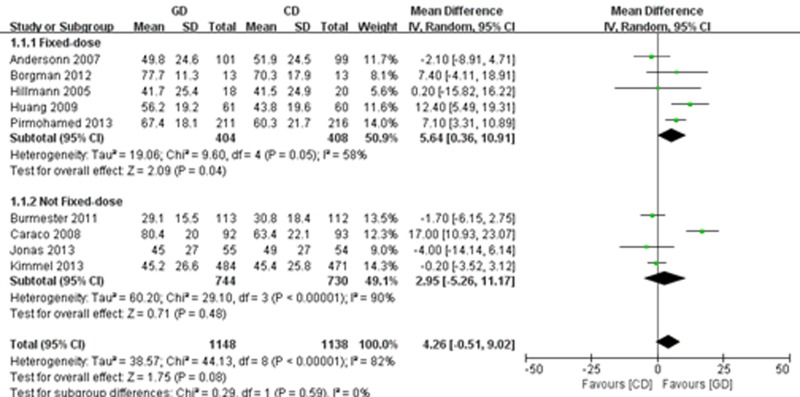
Forest plot of the time within therapeutic range (TTR).